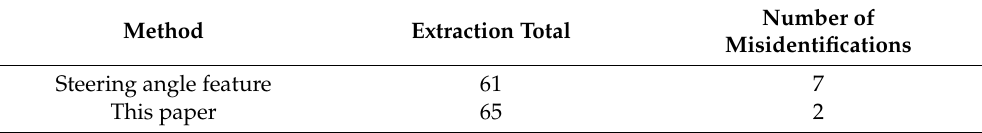
Figure 13. Location of real intersections in the area of the dataset. Table 1. Comparison of intersection extraction Table 1. Comparison of intersection extraction methods.